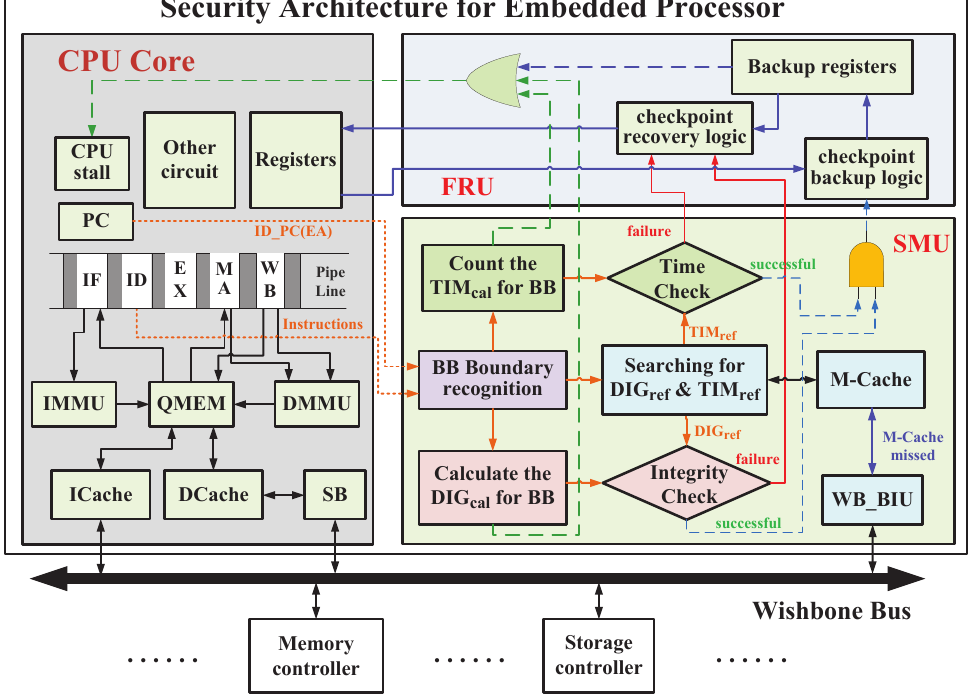
Figure 3. The structure of security monitoring and recovery